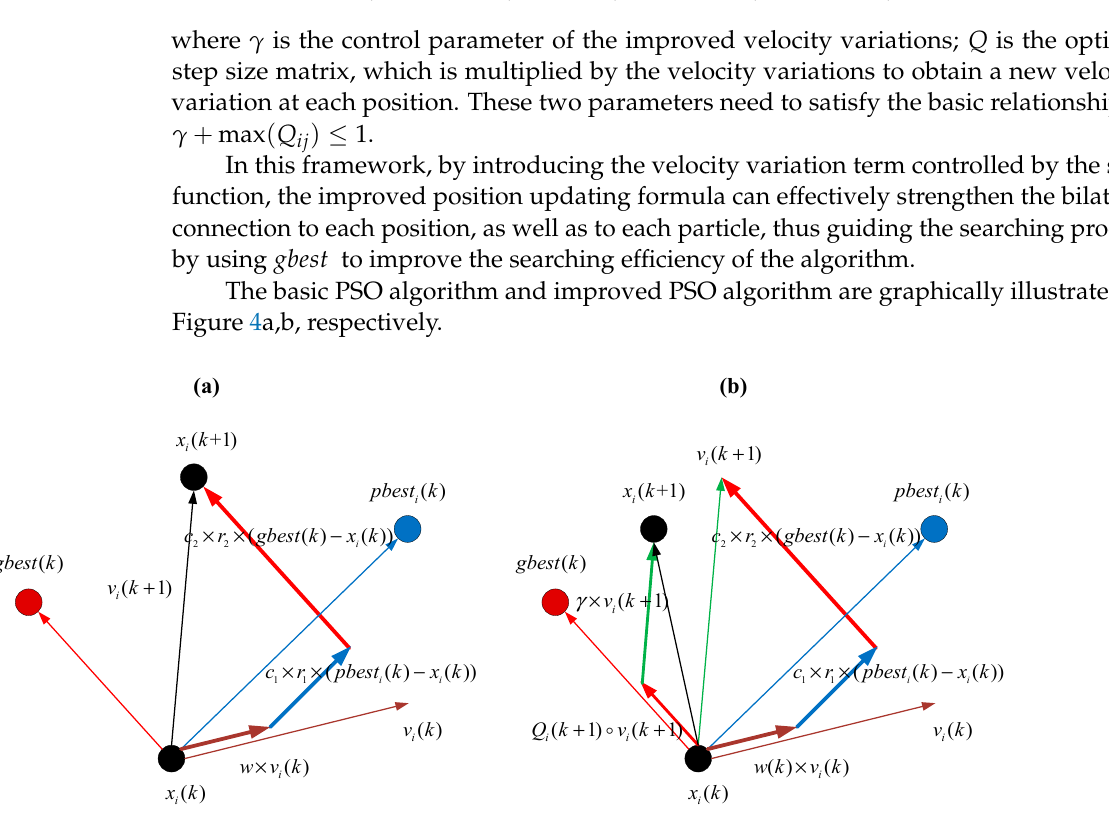
Figure 4. Graphical illustration of the different algorithms: ( a ) basic PSO algorithm; ( b ) improved PSO algorithm.